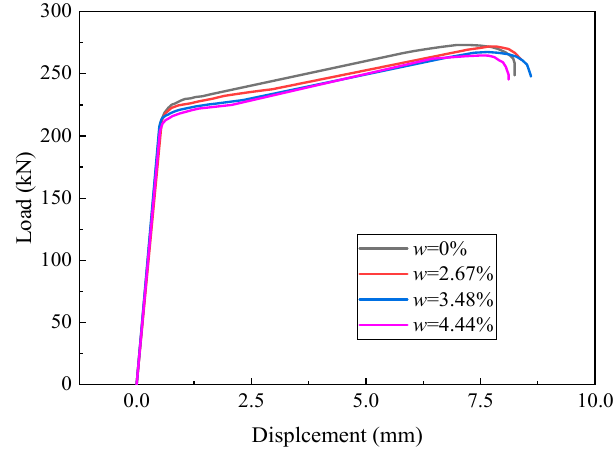
Figure 10. Load-displacement curves of the corroded bolt-sphere connections. When compared with the uncorroded specimen, the yield load of specimen C-1 Table 6. Results of the tensile properties of the corroded bolt-sphere connections. decreased by 0.83%, the yield load of specimen C-2 decreased by 3.02%, and the yield load for the specimen with the corroded degree of 4.44% decreased by 9.4 kN, accounting for 4.16% of the yield load for the uncorroded specimen. The ultimate tensile loads of all specimens changed a little, and the ultimate tensile load of the specimen corroded for 45 days decreased by 8.51 kN compared with the uncorroded specimen, accounting for a drop of 3.11% in the ultimate load of the uncorroded specimen. According to the analysis results, the influences of corrosion on the stiffness, yield load, and ultimate load of bolt-sphere connectors was less than 5%, indicating that the influences of corrosion on the tensile properties of bolt-sphere connectors are small.